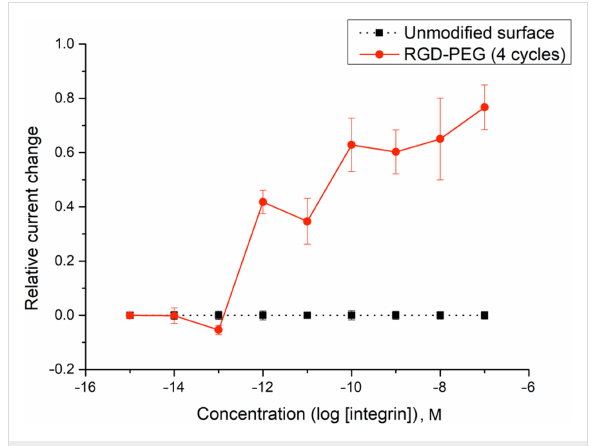
Figure 4: A model study using an RGD peptide (C-PEG6-GGRGDGP) and integrin receptor ( α 5, β